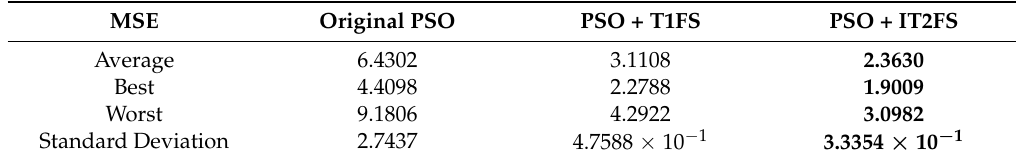
Table 11. Comparison of results from the plant with noise.